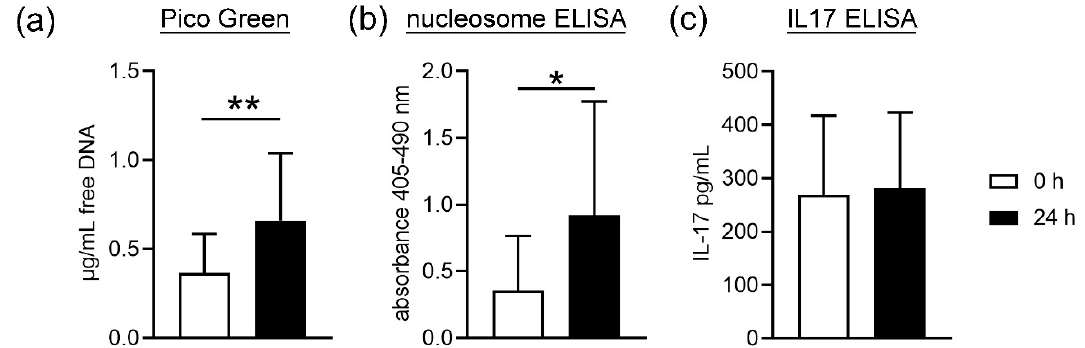
Figure 1. ( a ) Significantly higher concentrations of free DNA and ( b ) nucleosome were detected in the plasma obtained from stored blood. ( c ) The amount of IL17 was not different in plasma from fresh and stored blood. Data were analyzed with one-tailed paired Student’s t -test (a-b: n = 10; c: n = 9) and presented with mean ± SD, (* p < 0.05, ** p < 0.01).